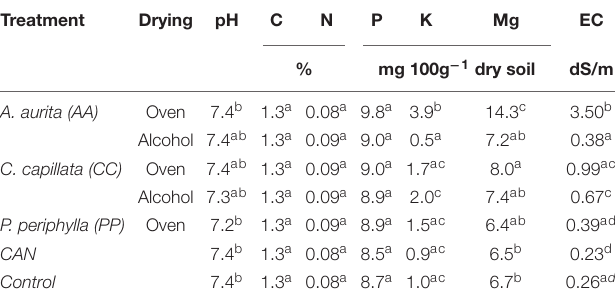
TABLE 3 | Soil chemical properties after the experimental duration among the different treatments. Salinity measured as electrical conductivity (EC). Treatment